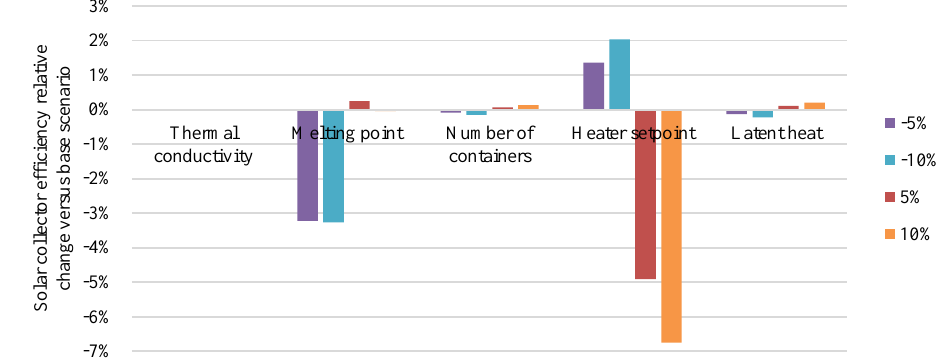
Fig. 5. Solar collector efficiency sensitivity.